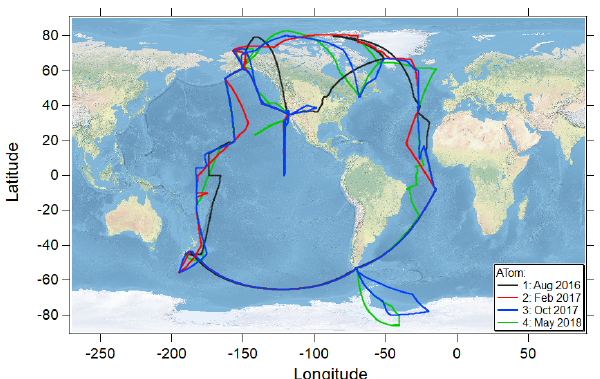
Figure 1. Flight tracks of the NASA DC-8 research aircraft during the ATom 1 (July–August 2016), ATom 2 (January–February 2017), ATom 3 (September–October 2017), and ATom 4 (April–May 2018) missions covering the remote marine atmosphere of the Pacific and Atlantic oceans between ∼ 83 ◦ N and ∼ 86 ◦